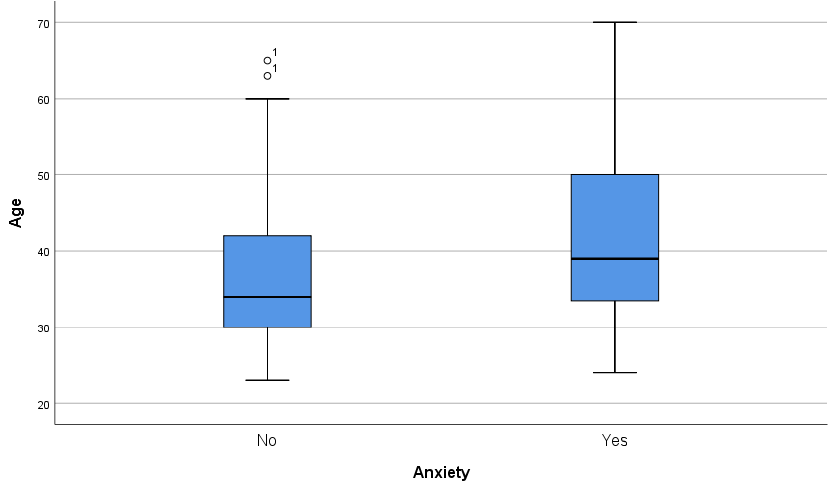
Figure 1. Box and whiskers graph, age, and depression diagnosis. 1 women, 0 men, * p < 0.05